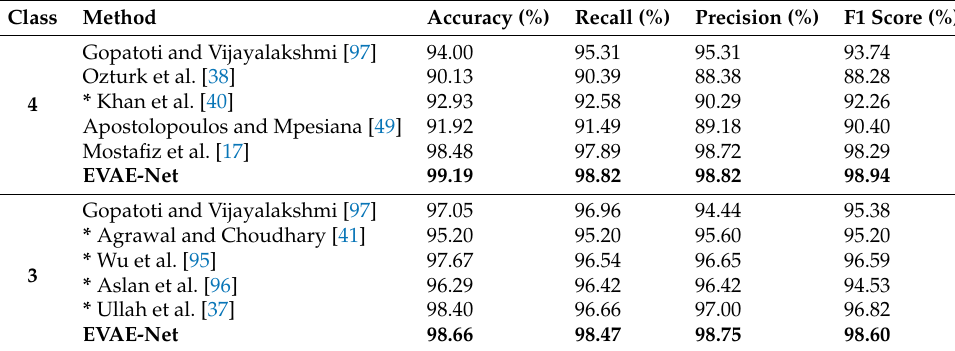
Table 12. Performance comparison of proposed model with existing studies. Methods with * used the COVID-19 Radiography